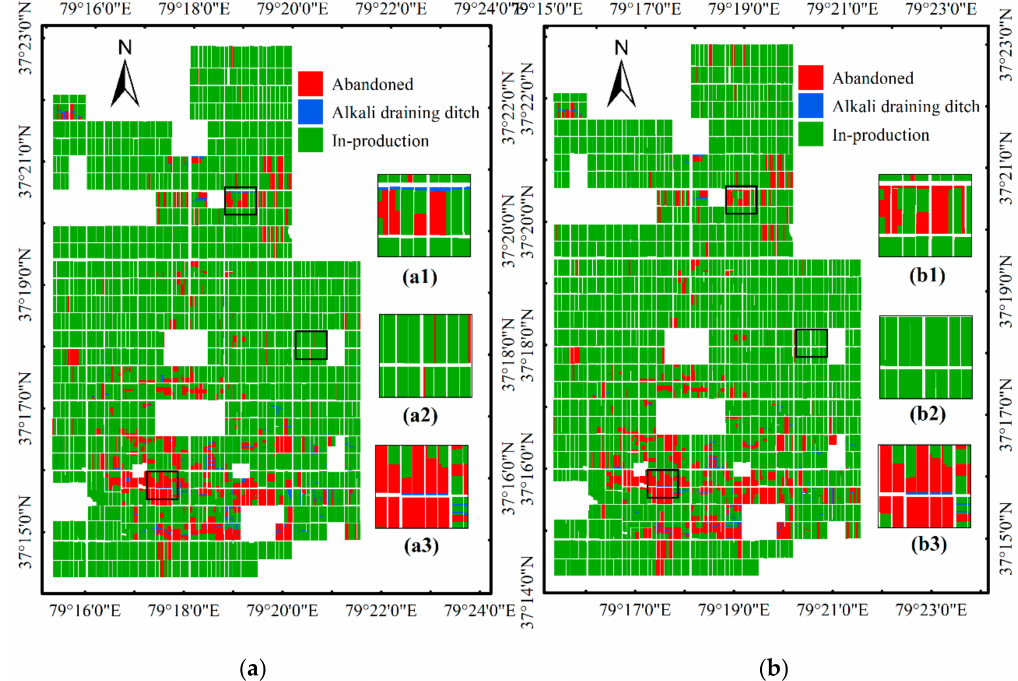
Figure 6. Land abandonment maps generated by ( a ) Model 1 and ( b ) Model 2 for the study area and the zoomed-in rectangle scenes ( a1 )–( a3 ) and ( b1 )–( b3 ) for the areas marked on the maps are shown at the